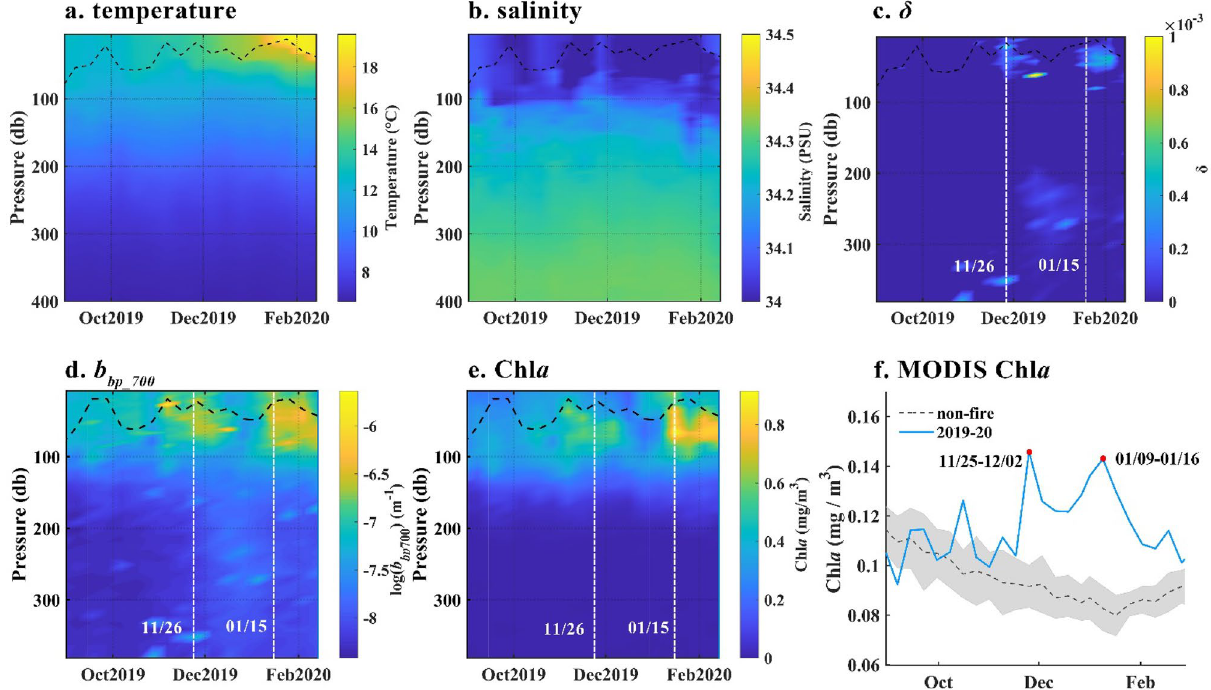
Figure 8. SOCCOM BGC-Argo float (No. 5904843) data and MODIS Aqua 8-day average Chl a in the same area. ( a ) temperature; ( b ) salinity; ( c ) δ ; ( d ) b bp_ 700 ; ( e ) Chl a ; ( f ) MODIS 8-day average Chl a . No. 5904843 float was located in the Southeast Pacific, which is shown in Fig. 1c. The dashed black lines indicate the MLD. The white dashed lines indicate the date when surface Chl a reached the